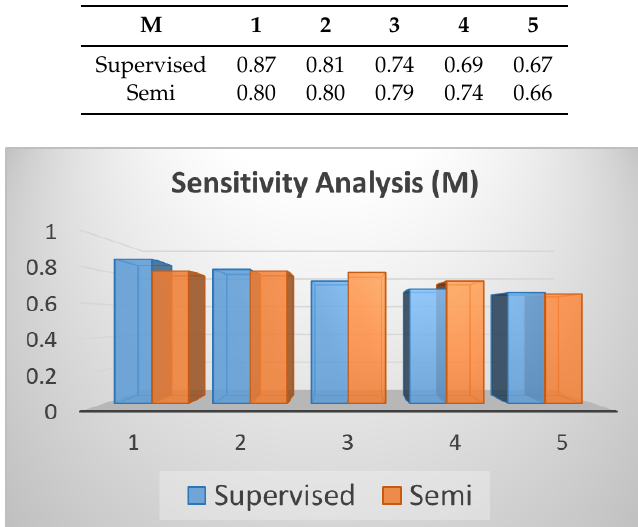
Figure 10. Sensitivity Analysis (M).